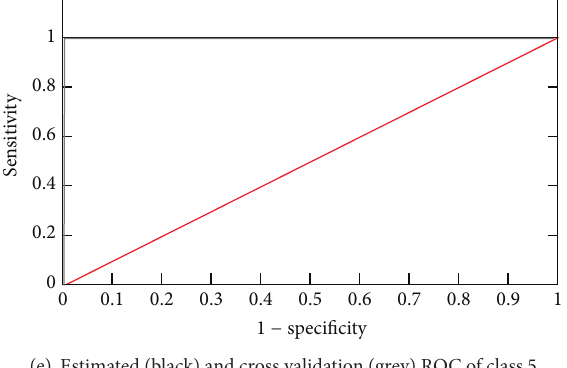
(c) Estimated (black) and cross validation (grey) ROC of class 3 (d) Estimated (black) and cross validation (grey) ROC of class 4